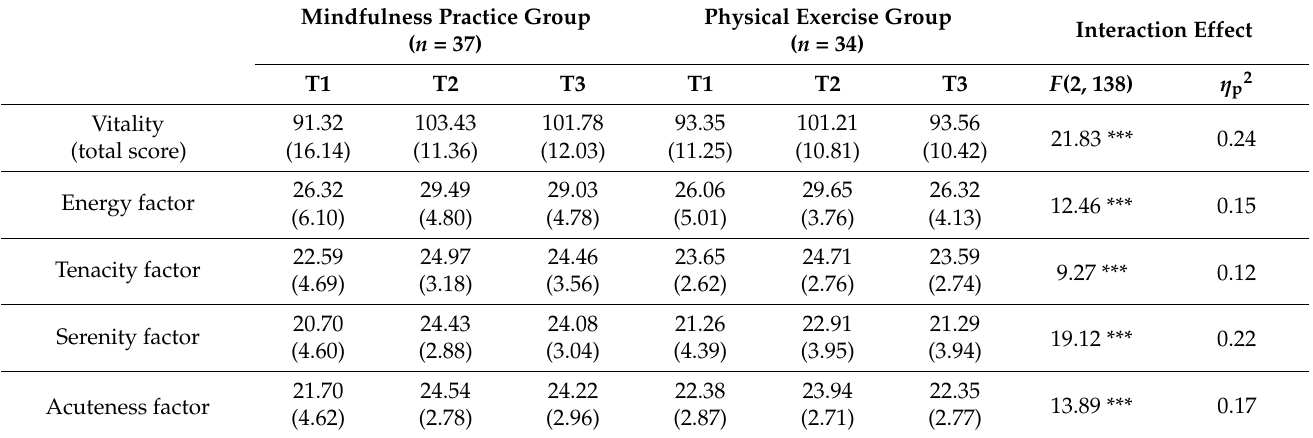
Table 2. Levels of vitality and its factors and the interaction effects between group and time